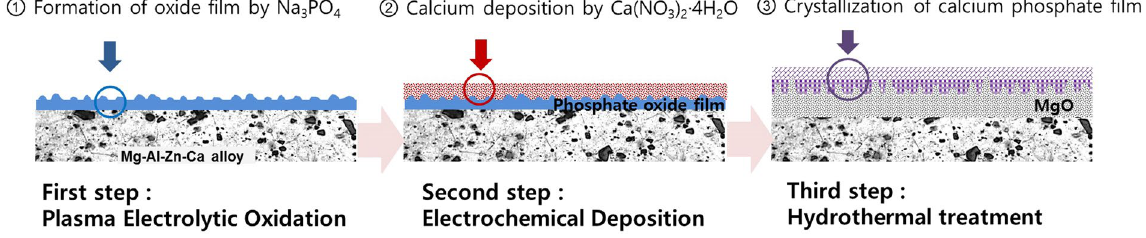
Figure 1. Schematic of surface-treatment